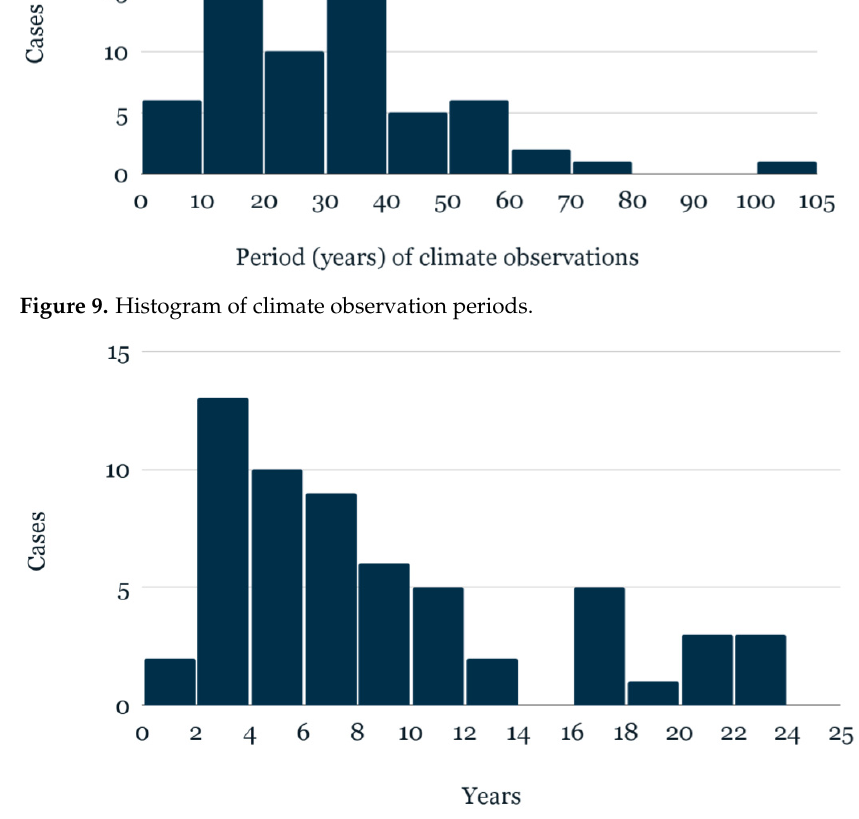
Figure 10. Histogram of years passed from last observation date to publication.